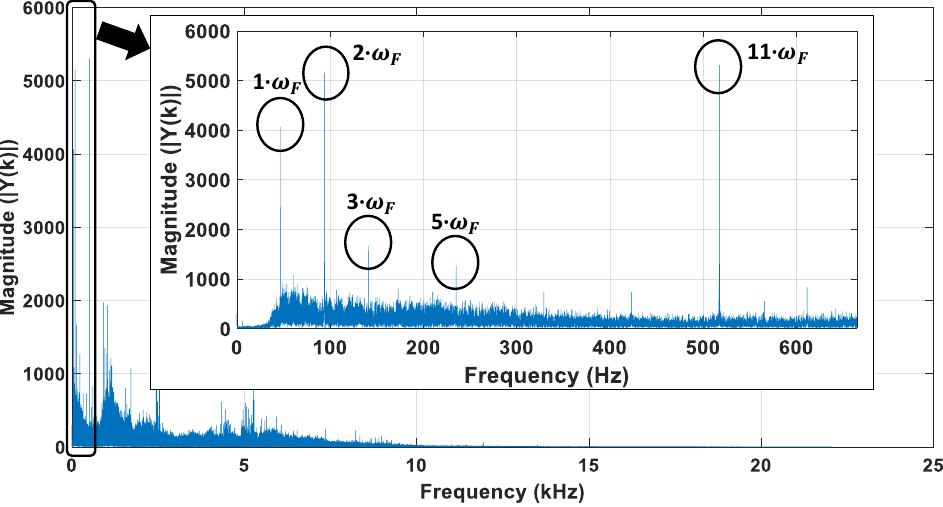
Figure 3. Frequency spectrum of the motor noise signal for no-load at 2820 r/min (295.3097 rad/s).